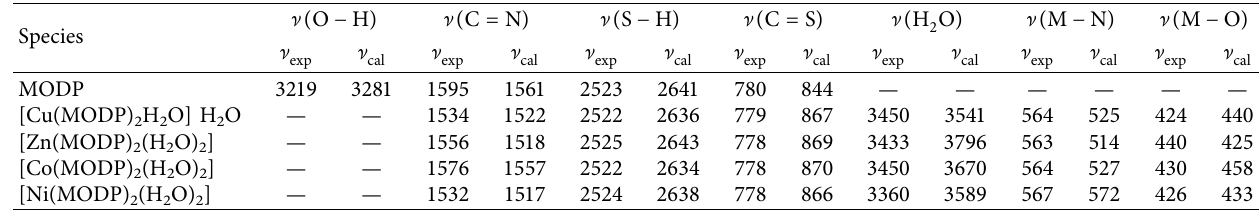
Table 2: Calculated vibrational frequencies (cm -1 ) for MODP and its complexes at B97-3c level and the corresponding experimental IR frequencies.